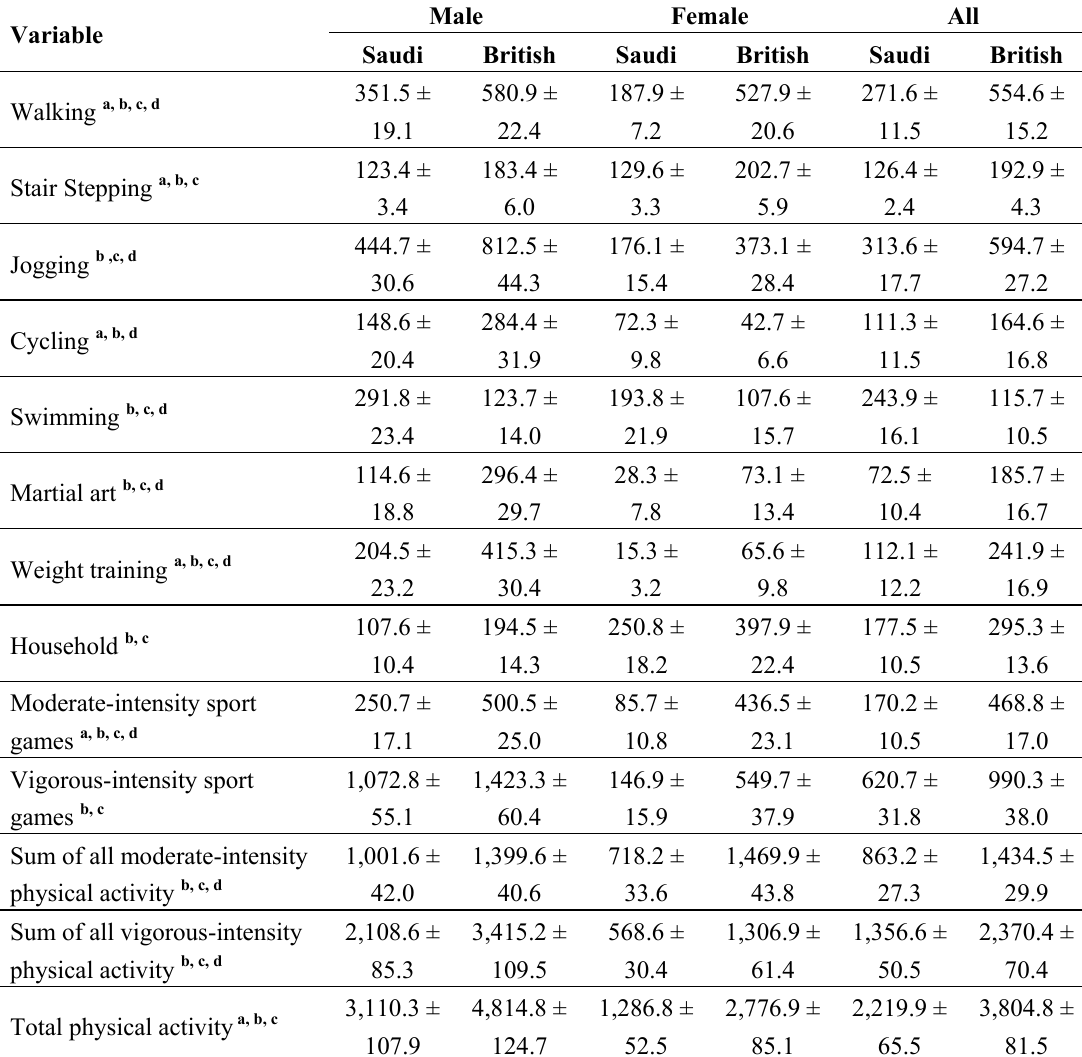
Table 2. Physical activity among Saudi and British